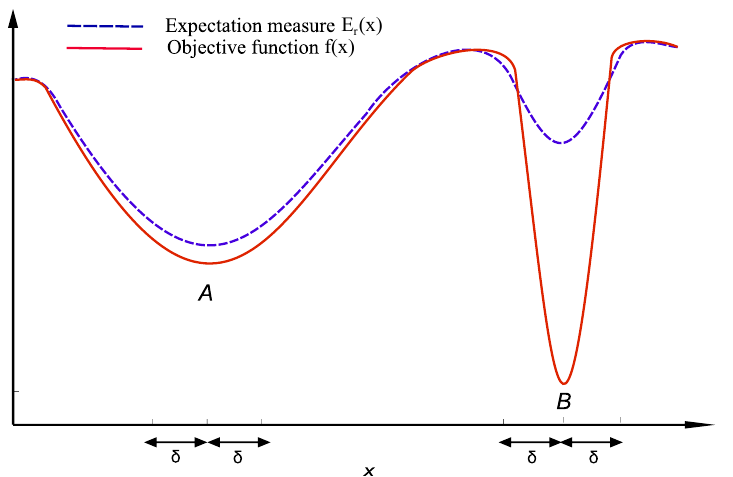
Figure 3. Illustration of the expectation measure E r in Equation (3) versus the traditional cost